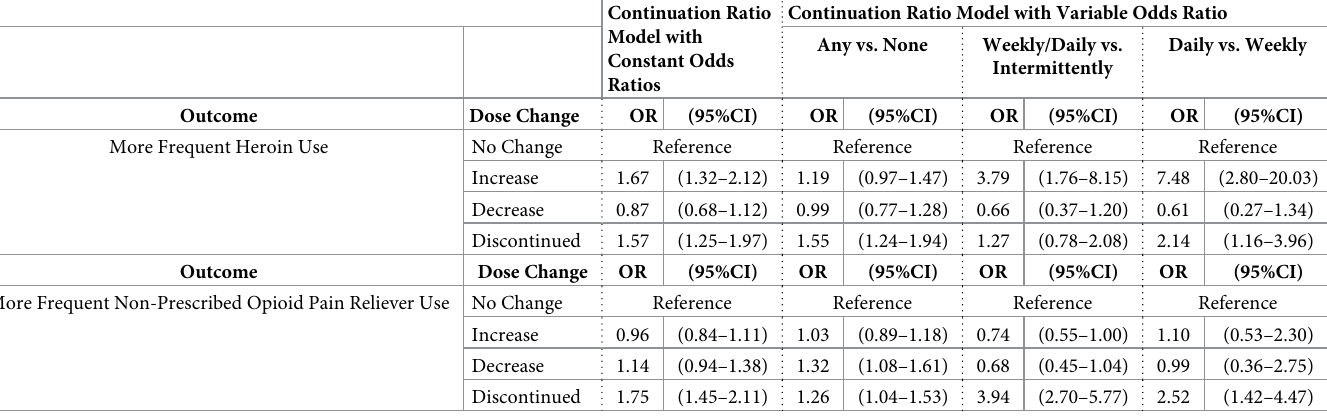
Continuation Ratio Model